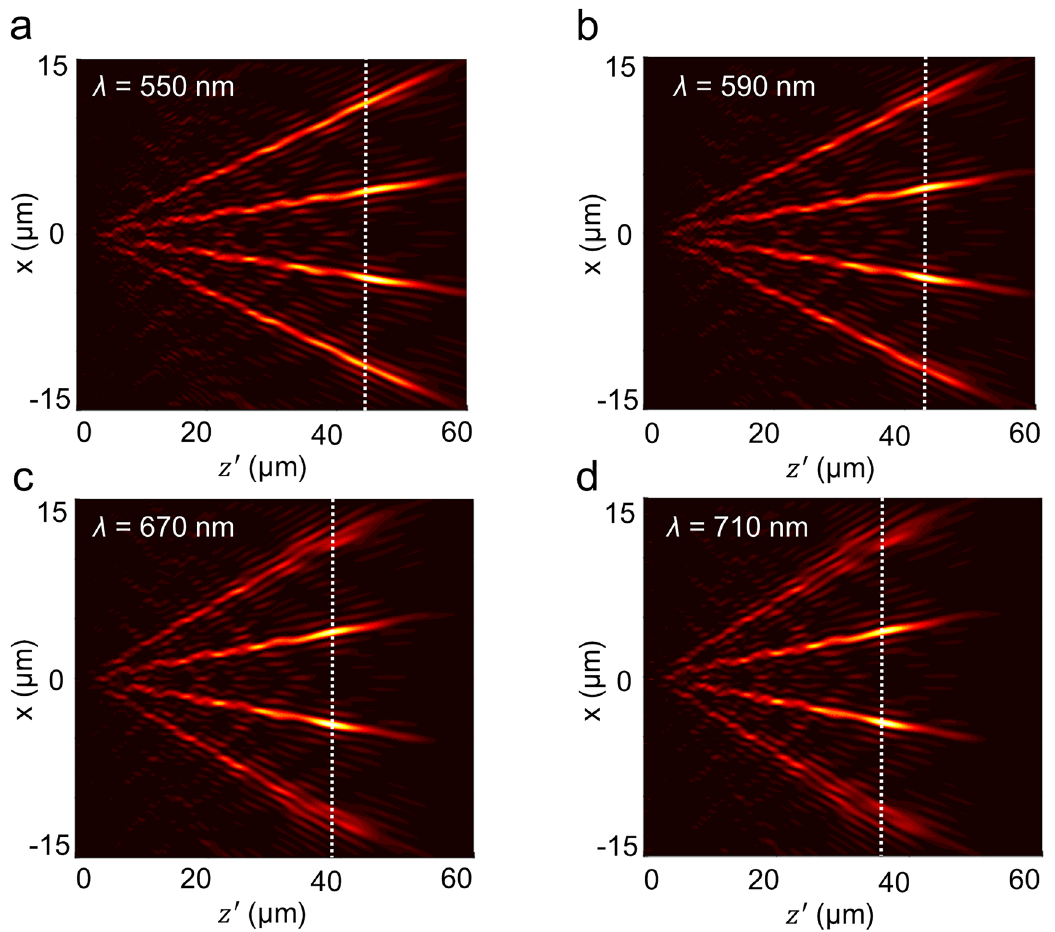
Figure 6: FDTD simulations of a 1 × 4 array of Bessel beams with NA = 0.4 ( λ = 630 nm,) at various wavelengths λ = 550 nm, 590 nm, 630 nm, 670 nm, and 710